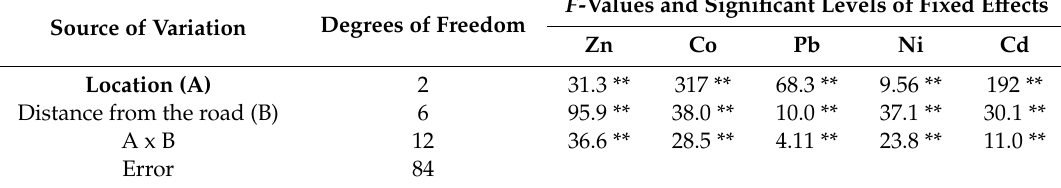
Table 3. Analysis of variances ( F -test) of the contents of potentially toxic elements in moss from five-year monitoring research (significant at ** p <